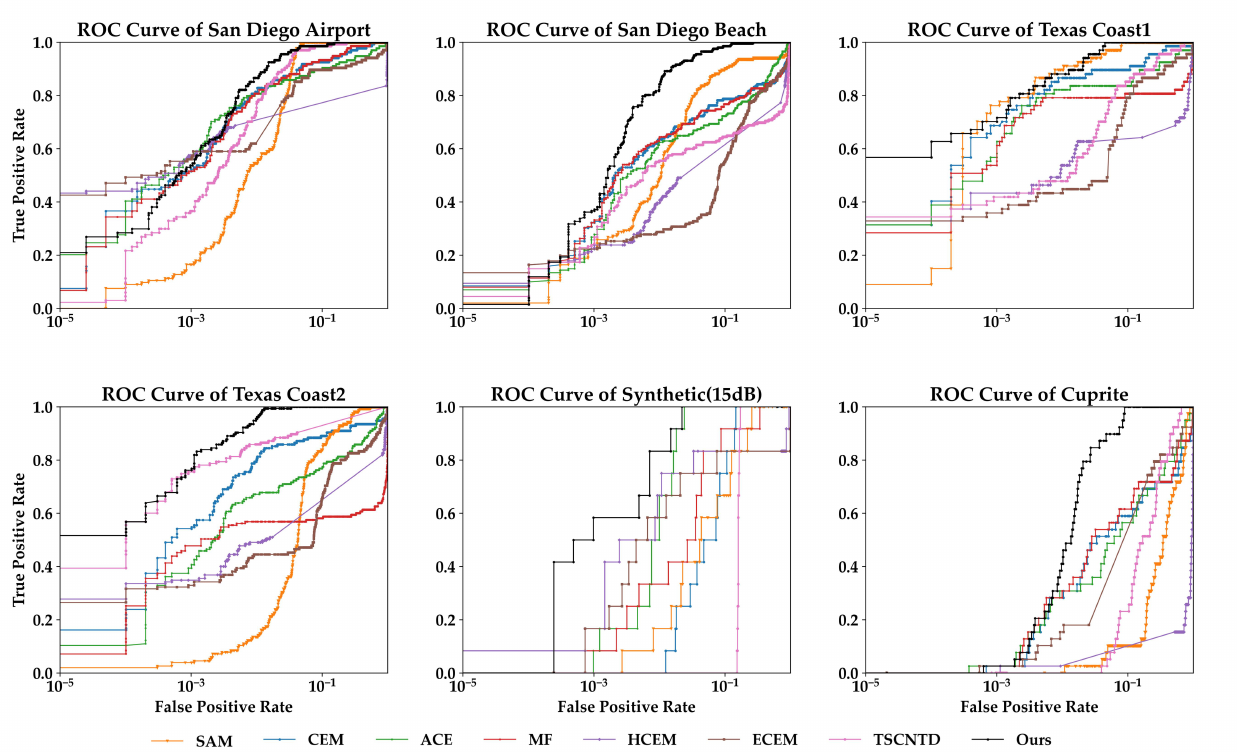
Figure 11. Receiver operating characteristic (ROC) curves of all the test algorithms on the six data sets. The black lines represent the proposed Siamese detector ensembles ( N = 4).